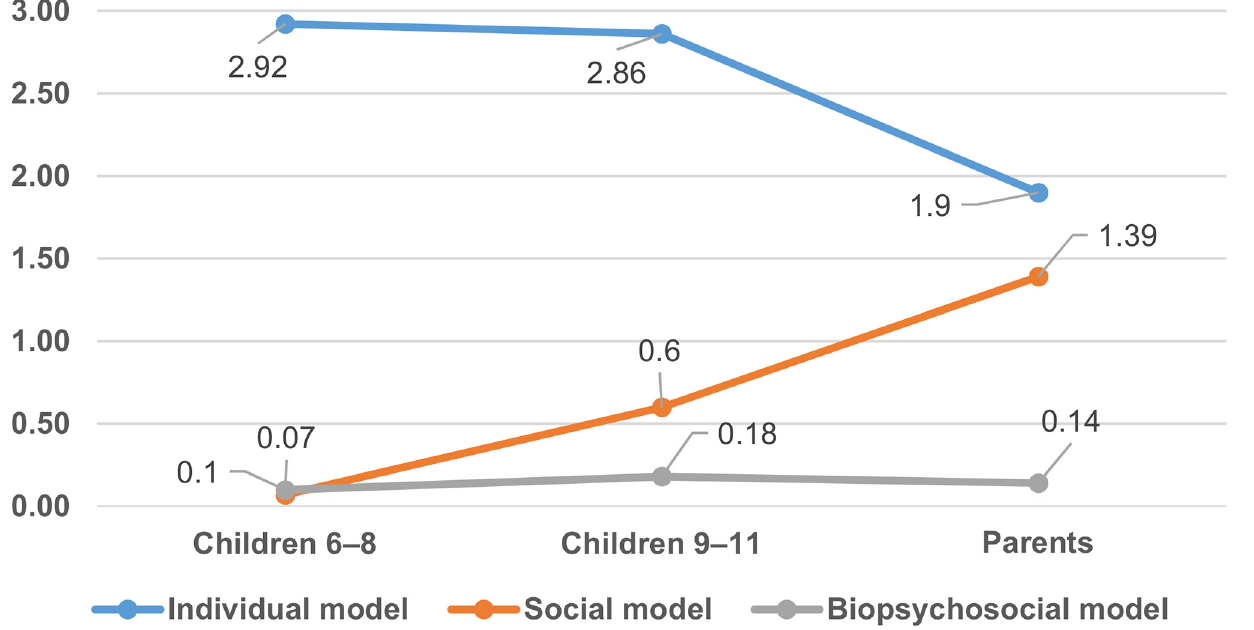
Fig 1. Disability Explanation — Open-Ended Questionnaire. Mean frequency preference for the three disability models by age group.